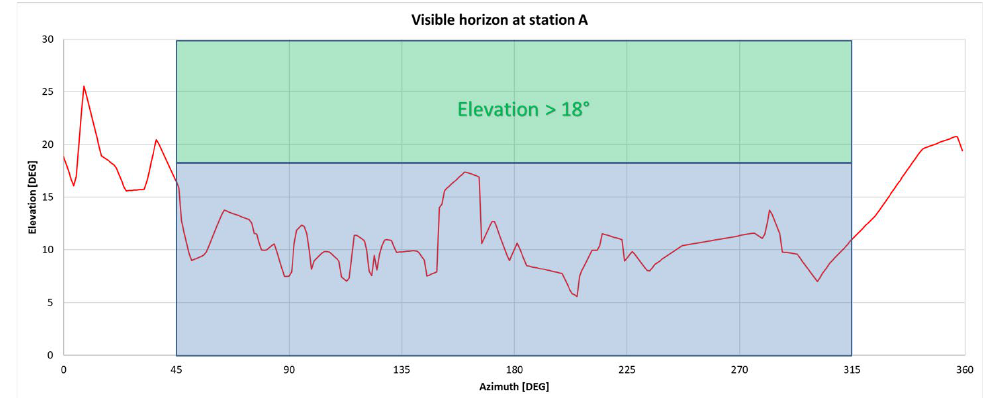
Figure 3. Visible horizon at station A (red line): maximum elevation (26 ◦ ) of the visible horizon is in the azimuth 9 ◦ ; in the portion of the sky 45 ◦ < Azimuth < 315 ◦ , the visible horizon is free above the elevation 18 ◦